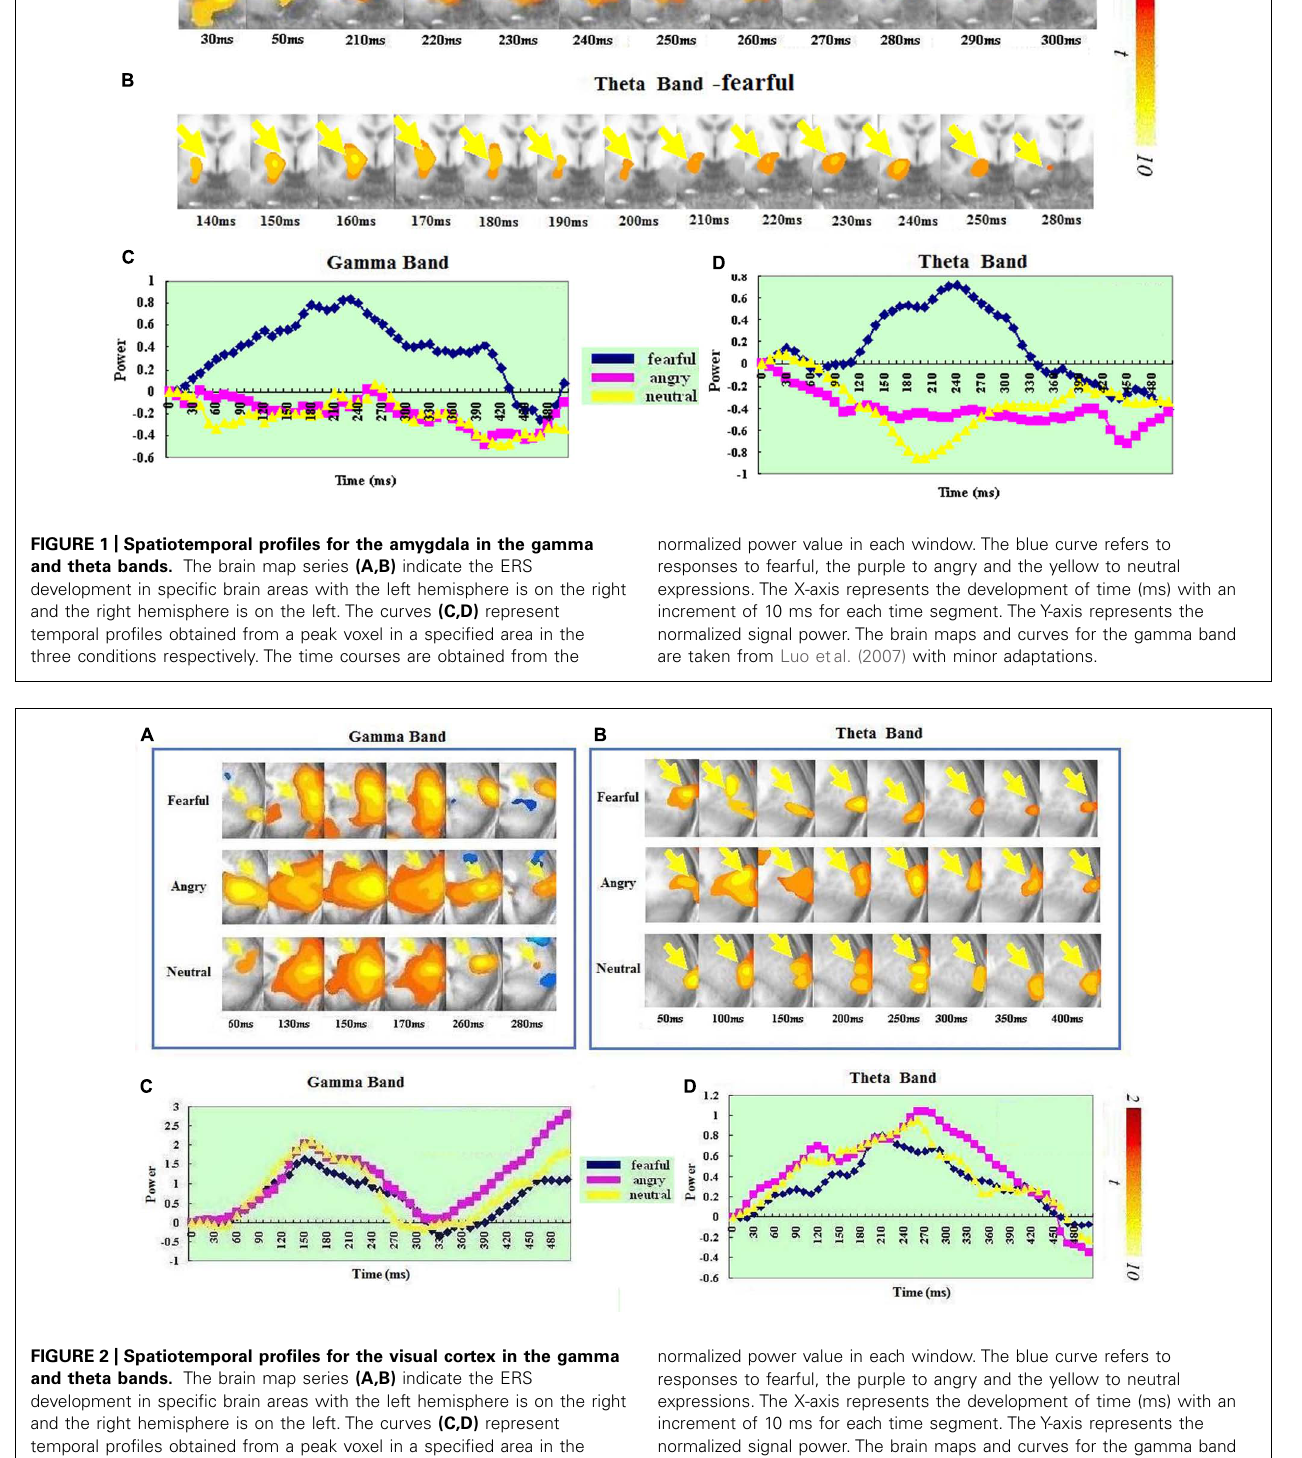
normalized power value in each window. The blue curve refers to responses to fearful, the purple to angry and the yellow to neutral expressions. The X-axis represents the development of time (ms) with an increment of 10 ms for each time segment. The Y-axis represents the normalized signal power. The brain maps and curves for the gamma band are taken from Luo etal. (2007) with minor